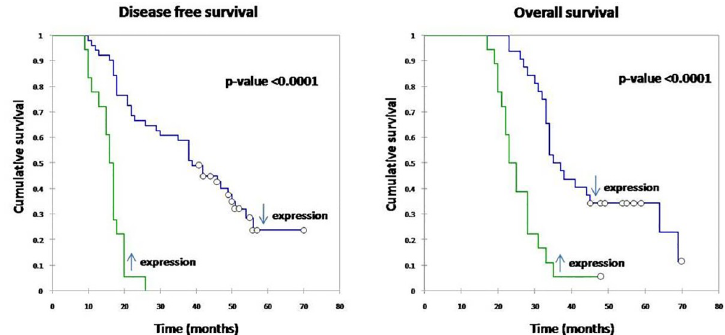
Fig 1. Survival analysis of patients by Kaplan Meier method based on their microRNA expression (a) Disease free survival (DFS) (b) Overall survival (OS). Underexpression of miR levels (miR-18a and miR-182) was associated with improved DFS and OS (p-value < 0.0001).